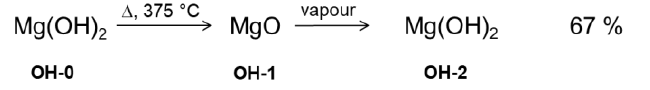
Figure 1. SEM pictures of ( a ) Mg(OH) 2 ; ( b ) MgCO 3 ; ( c ) MgC 2 O 4 ∙2H 2 O before calcination (first row) and after calcination (second row).